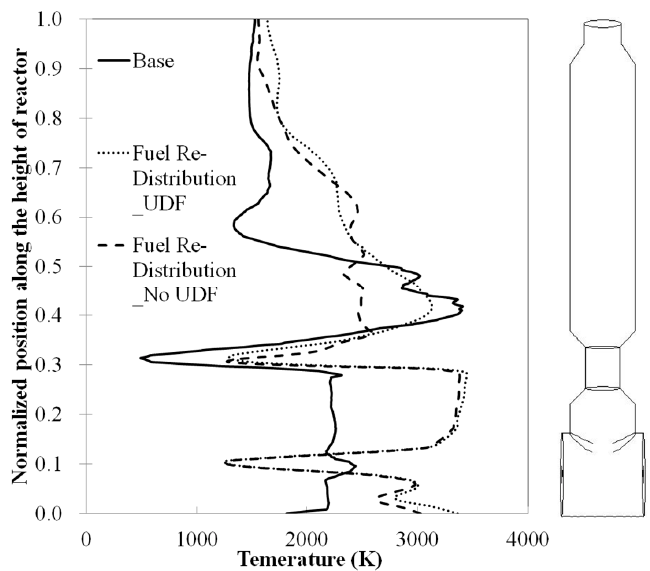
Figure 4. Effect of fuel re-distribution on temperature distributions with and without condensation and re-vaporization sub-models. The exit temperatures and the interior temperature distributions are quite different. In the base case, the average temperature in the first stage (with recycled char) is about 2200 K. In the case of fuel re-distribution, there is a low temperature region in the first stage since the recycled char is injected at the second stage. With 80% coal-slurry and recycled char, the temperature at the second stage is higher than that of base case. Therefore, using fuel re-distribution leads to lower first stage temperature and higher second stage temperature. Fuel-redistribution also results in higher outlet temperature. The temperature distribution of the base case is more preferable because the wall temperature is relatively low and the hot spot region is less noticeable, as illustrated in Figure 5; hence, the refractory can last longer.